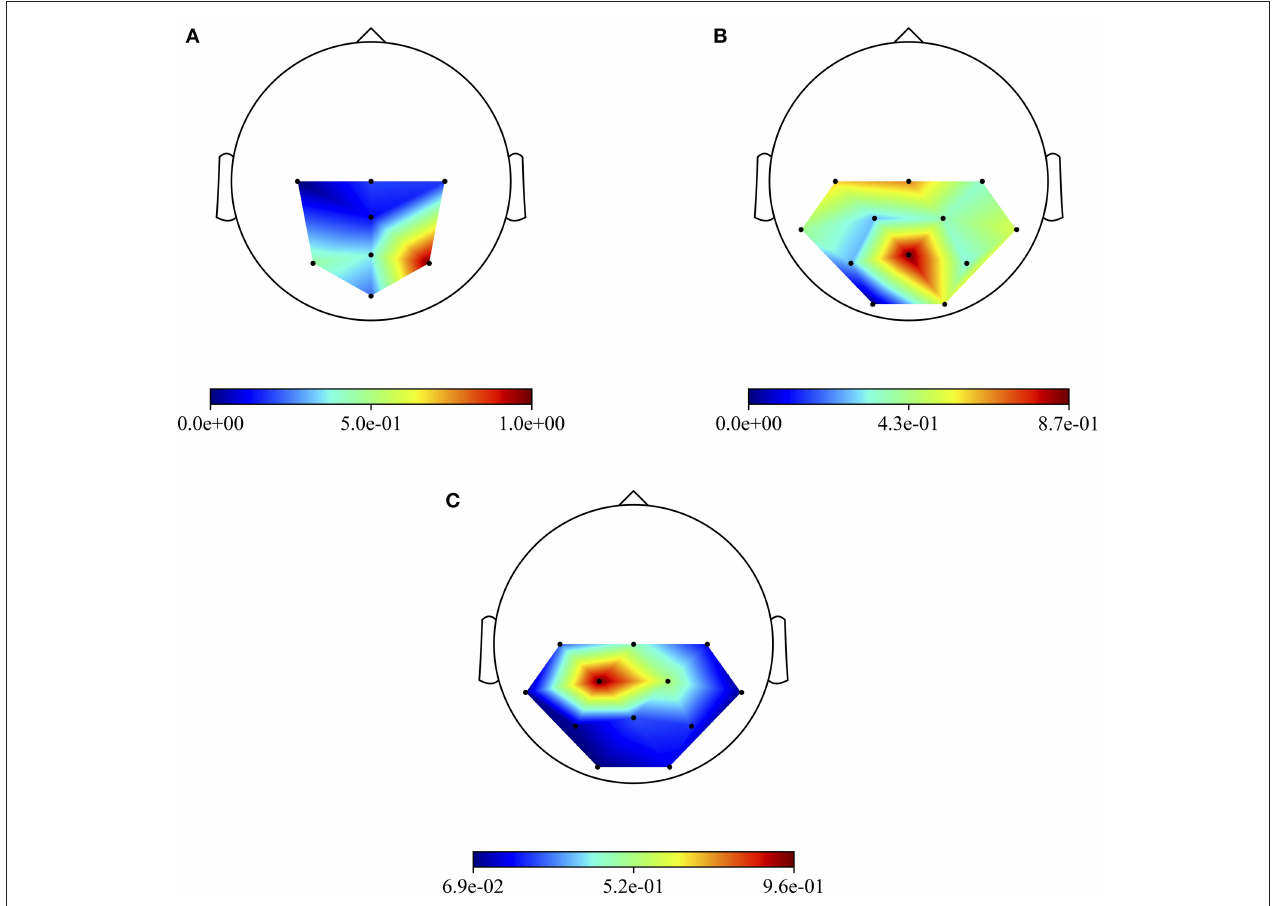
FIGURE 6 | Grand average absolute spatial representations of MS-EEGNet trained with the LOSO strategy using signals from datasets 1–3 (A–C) .